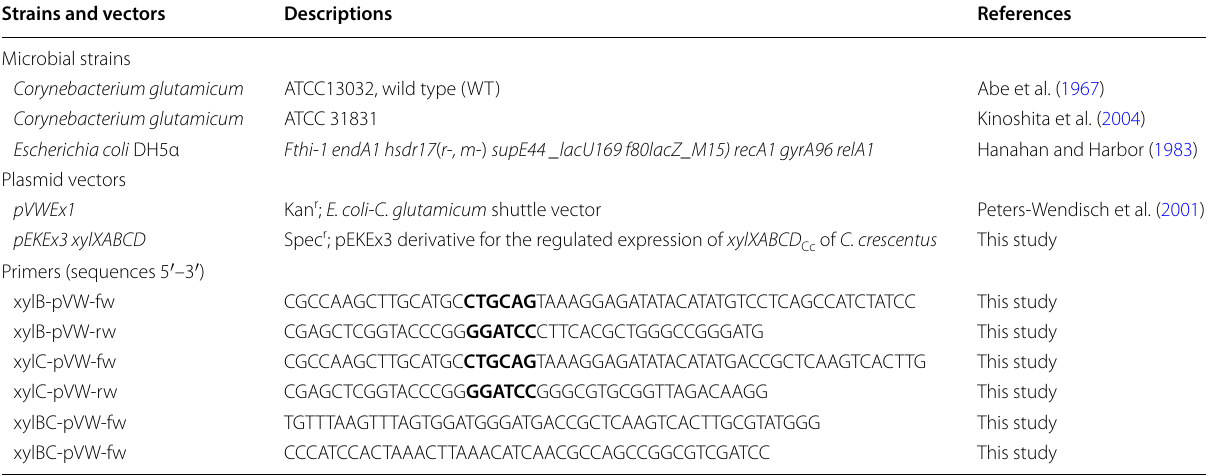
Table 1 Microbial strains, plasmids and primers used in the study Strains and